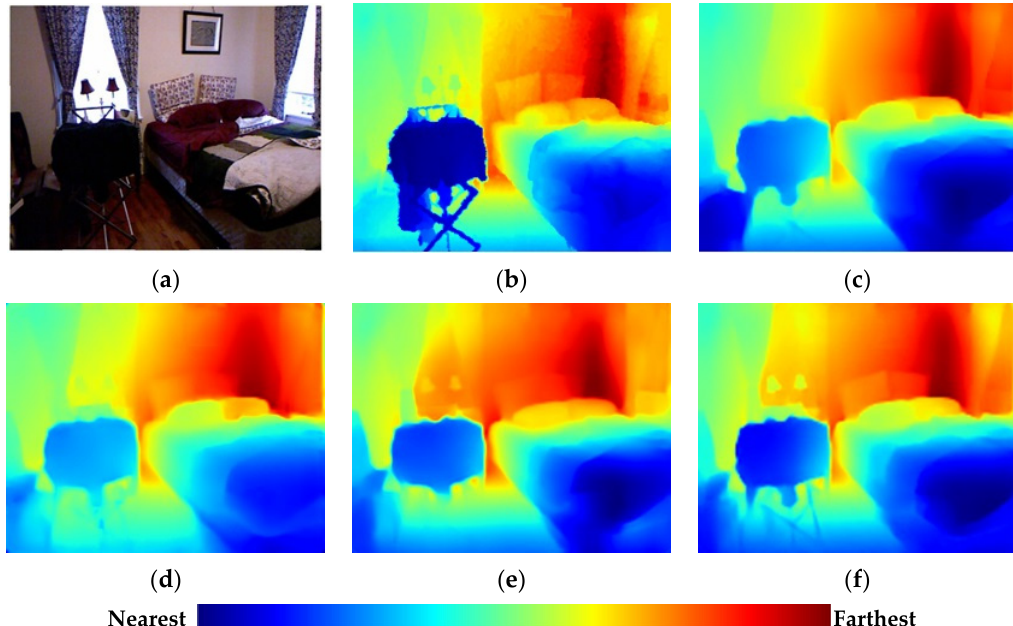
Figure 1. A depth estimation example: ( a ) RGB image; ( b ) ground truth depth map; and ( c – f ) depth maps by Chen et al. [20], Alhashim et al. [17], Hu et al. [22], and the proposed method. We set colors of all indoor depth maps in our work according to the distance as the color bar above.